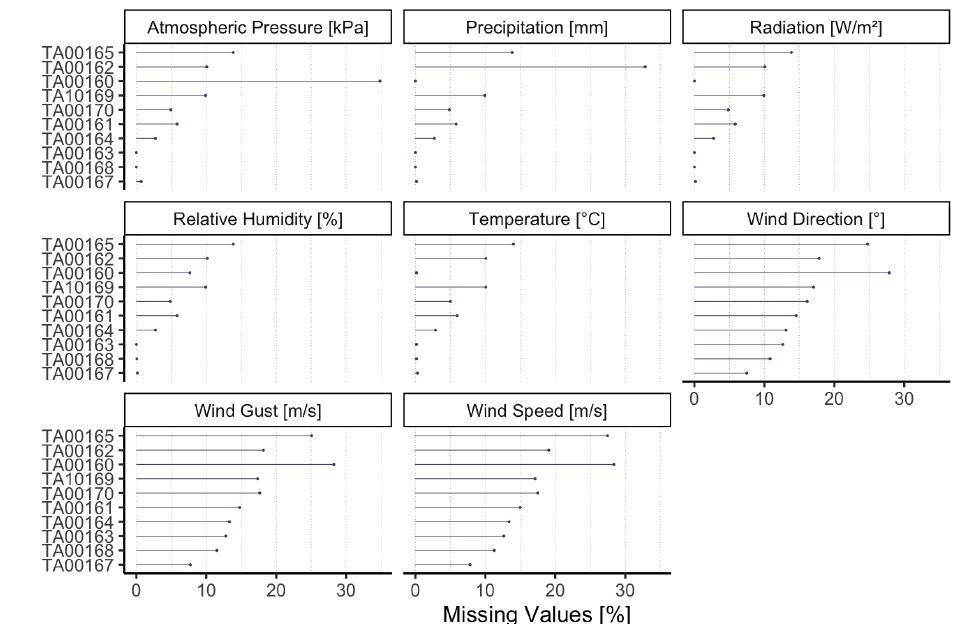
Figure 3. Number of missing values (MVs) (%) for all variables measured by TAHMO in Burkina Faso within the period 06/20/2017–12/31/2020, and the pre-selected 10 hydro-meteorological TAHMO stations in Burkina Faso.